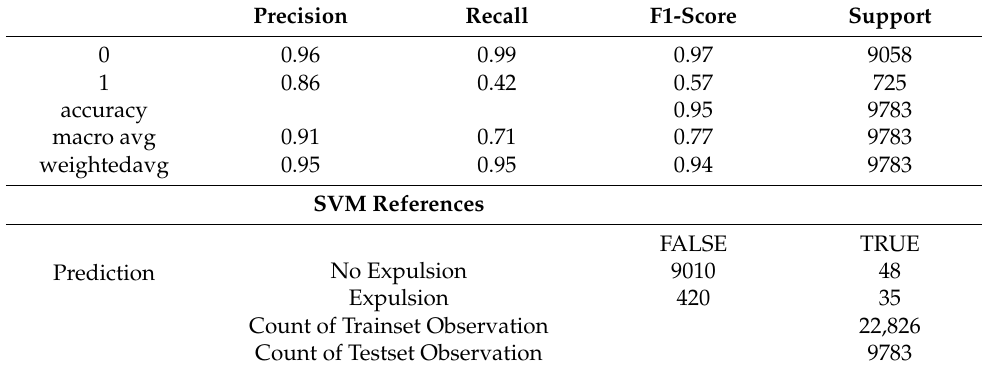
Table 10. Confusion matrix score for SVM.